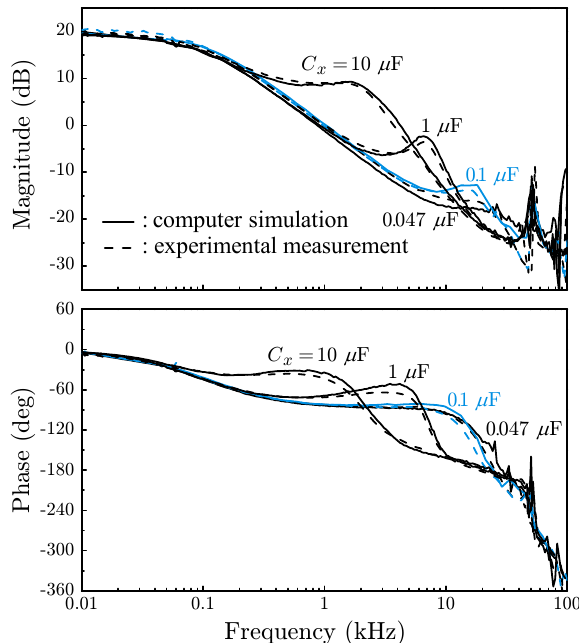
Figure 6. Control-to-output transfer function with different filter capacitance.